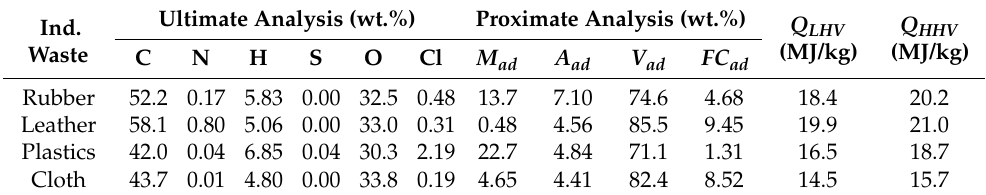
Table 1. The ultimate and proximate analysis of individual polymeric wastes. Ind.